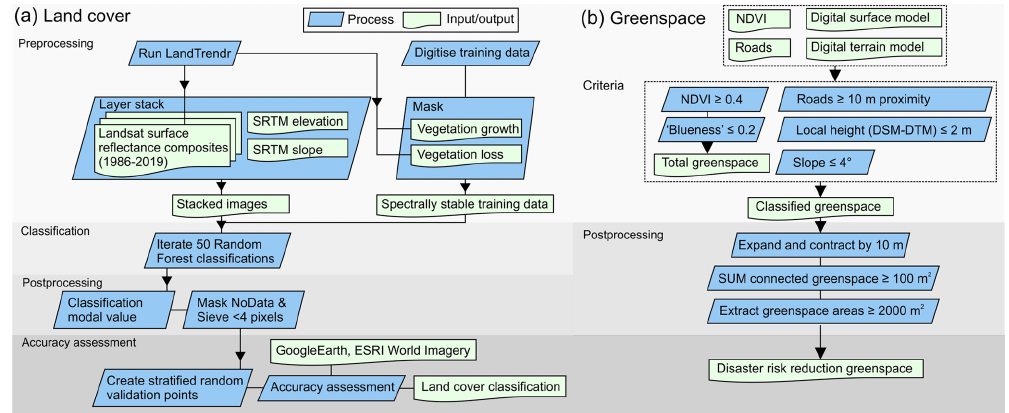
Figure 3. (a) Land cover classification and accuracy assessment workflow. (b) Classification of greenspace that could potentially contribute to disaster risk reduction (DRR), herein “DRR